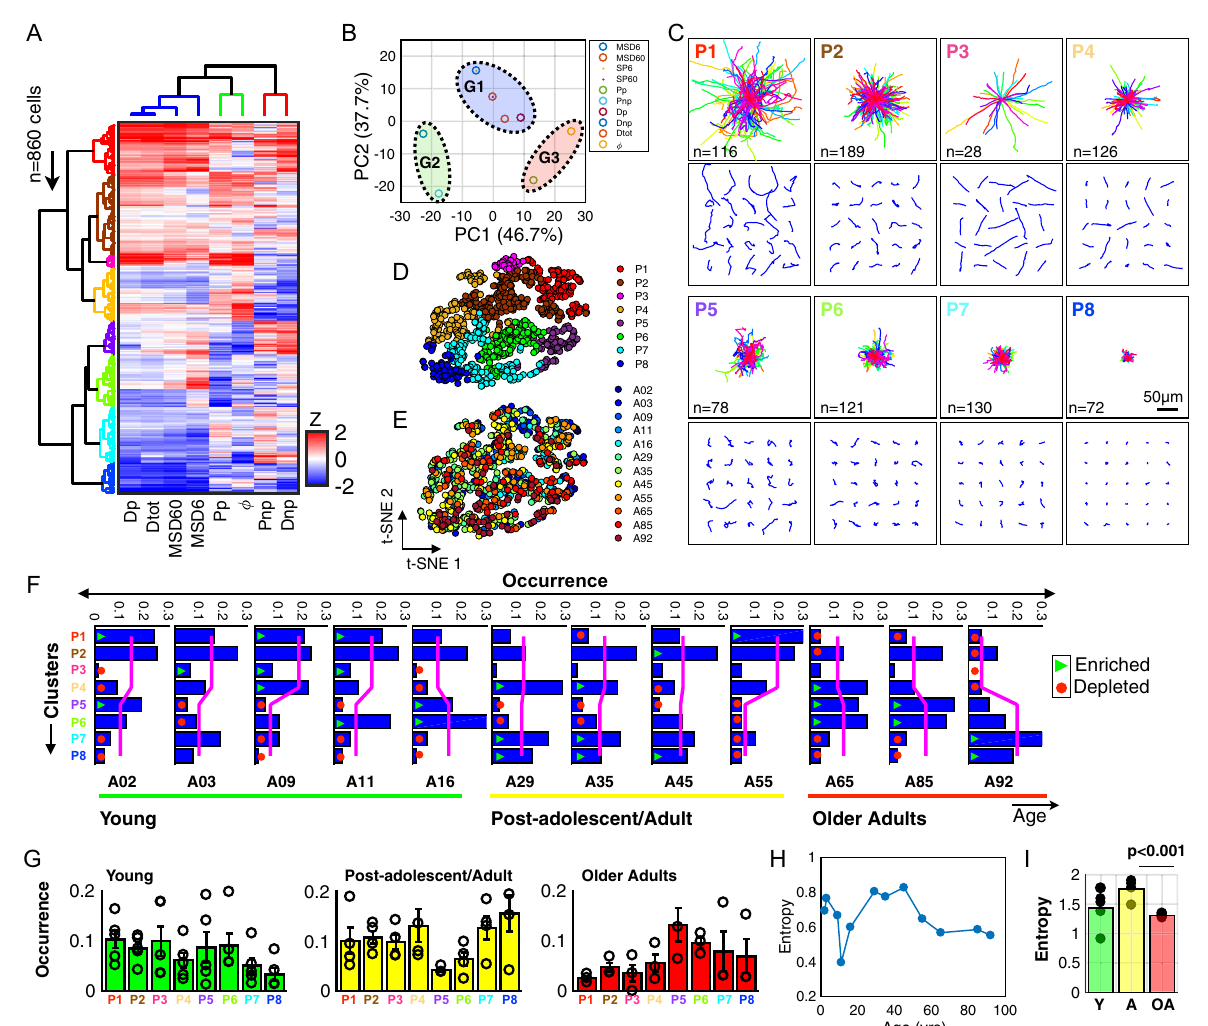
Fig. 2 Age-associated spatial motility patterns at the single-cell level. A Heatmap showing eight motility parameters measured at the single-cell level across all ages ( n = 860 cells); each row represents a single cell and each column a motility parameter. Dendrogram branches represent hierarchical clustering using the city block distances with ward linkage along axes of maximum variation. Data shows the delineation of single cells into eight spatial motility clusters, with the column-clusters ( n = 3 clusters) describing the degree of cellular displacements, and spatio-temporal persistence. B Principal component analysis (PCA) of the eight motility parameters showing the delineation into three groups, G1-high displacement cells, G2-persistent, and G3- non-persistent. C x – y trajectories based on the eight clusters that delineate patterns of cellular movements. Top panels show the origin-centered trajectories for all cells within clusters; bottom panels show x – y trajectories for 25 randomly selected cells per cluster, with the number of cells per cluster indicated in each plot, scale bar = 50 µ m. D Two-dimensional t-SNE visualization for the eight color-coded spatial clusters. E Age-painted t-SNE plot showing the distribution of ages per spatial motility cluster. F Frequency distributions indicating the fractional composition of cells per cluster as a function of age. Magenta trend lines represent the average fraction per primary branch of the dendrogram tree. The fi rst bifurcation delineates four clusters each. Trend lines show a progressive transition in the abundance of cells across primary branches with increasing age, green triangles denote signi fi cantly enriched and red circles denote signi fi cantly depleted ( p -value < 0.05). G Frequency distributions showing the average fractional abundances of cells per cluster separated into three groups, data points per age shown as black points and error bars indicate the standard deviation; young, post-adolescent/adult, and older adults. H Magnitude of the Shannon entropy for each individual sample with increasing age. I Average Shannon entropy based on these three age groups, showing a decrease in heterogeneity of motility from post-adolescent/adults to older adults ( p <